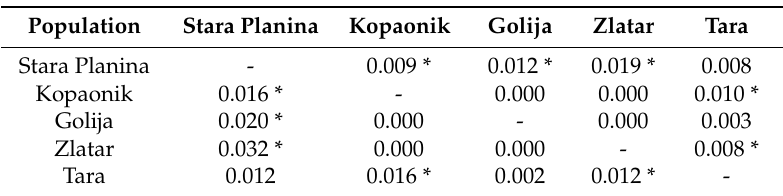
Table 5. Nei’s [37] unbiased genetic distance (below diagonal) and pairwise F st (above diagonal) among five Norway spruce populations in Serbia, calculated at five loci. Statistically significant departures from zero (F st ) at α = 0.05 are marked with an asterisk (*).